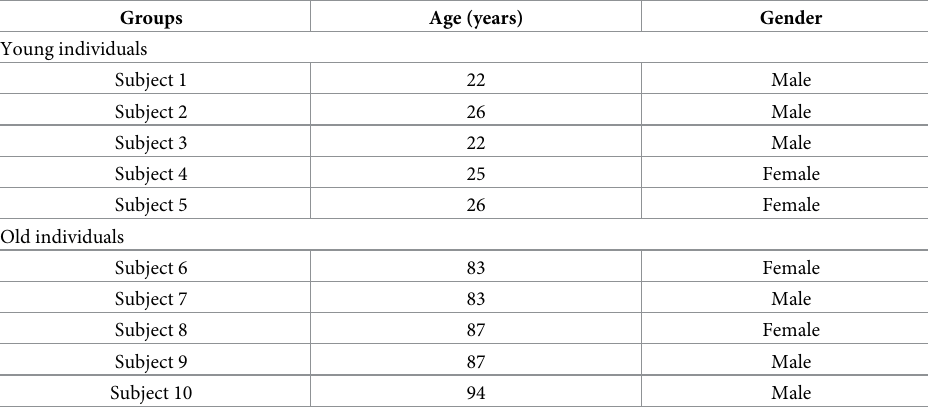
Table 1. Characteristic information of different age groups of subjects.